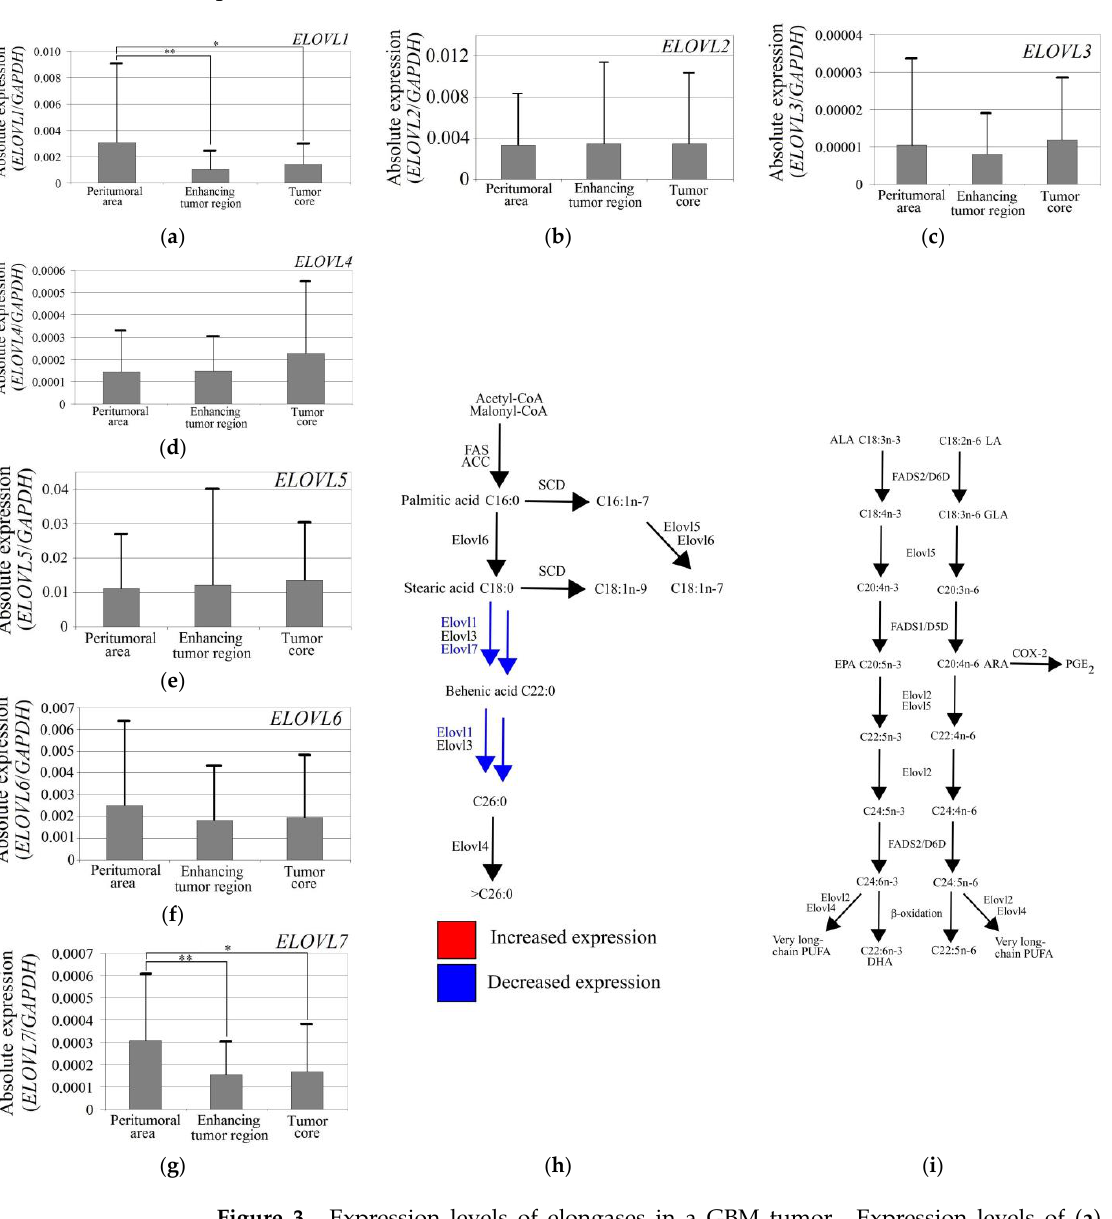
Figure 3. Expression levels of elongases in a GBM tumor. Expression levels of ( a ) ELOVL1 , ( b ) ELOVL2 , ( c ) ELOVL3 , ( d ) ELOVL4 , ( e ) ELOVL5 , ( f ) ELOVL6 , and ( g ) ELOVL7 in the peritumoral area, enhancing tumor area and tumor core. Changes in elongase expression affect the synthesis of ( h ) MUFA, SFA, and ( i ) PUFA. * — statistically significant difference of expression of a given elongase between different regions of a GBM tumor estimated by Wilcoxon signed-rank test ( p < 0.05). ** — p < 0.01.